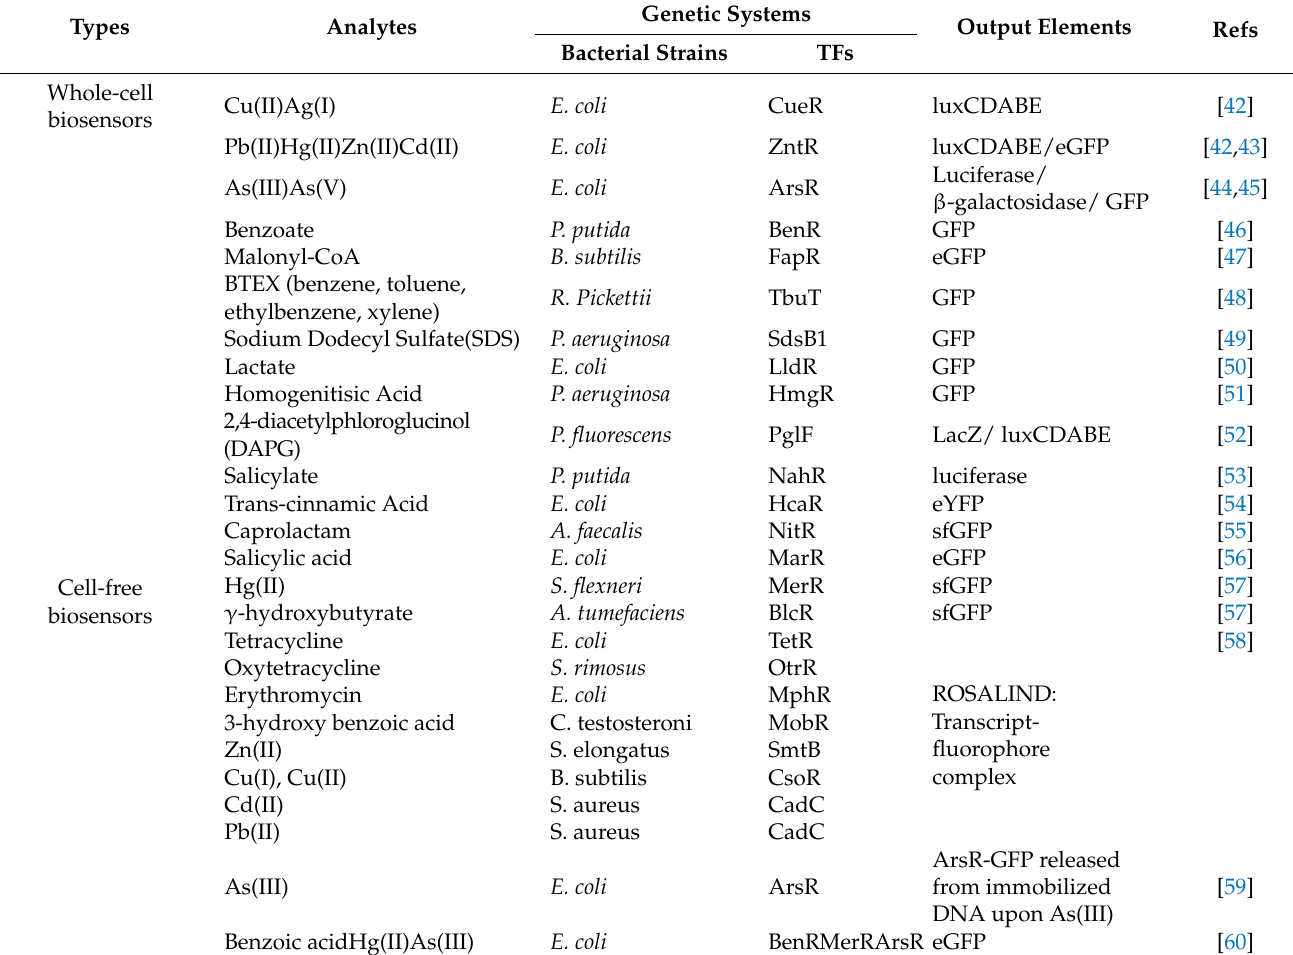
Table 1. Transcription factor-based